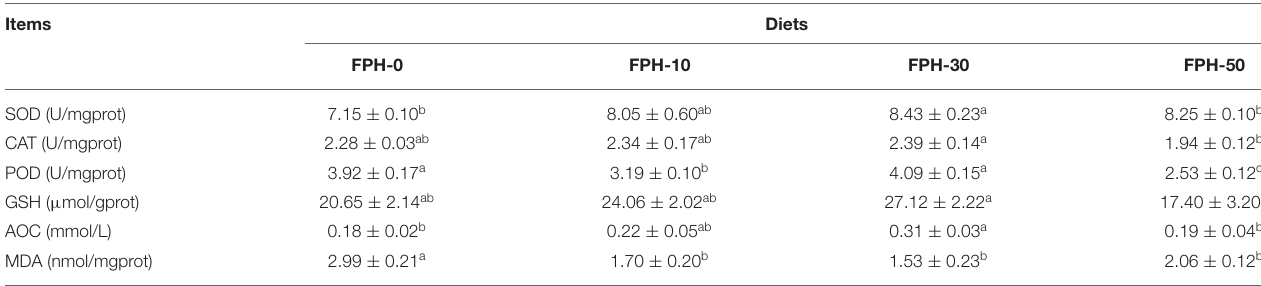
TABLE 7 | Antioxidant capacity in the intestine of largemouth bass ( Micropterus salmoide s) fed the diets containing different supplementation levels of fish protein hydrolysate (FPH)*.